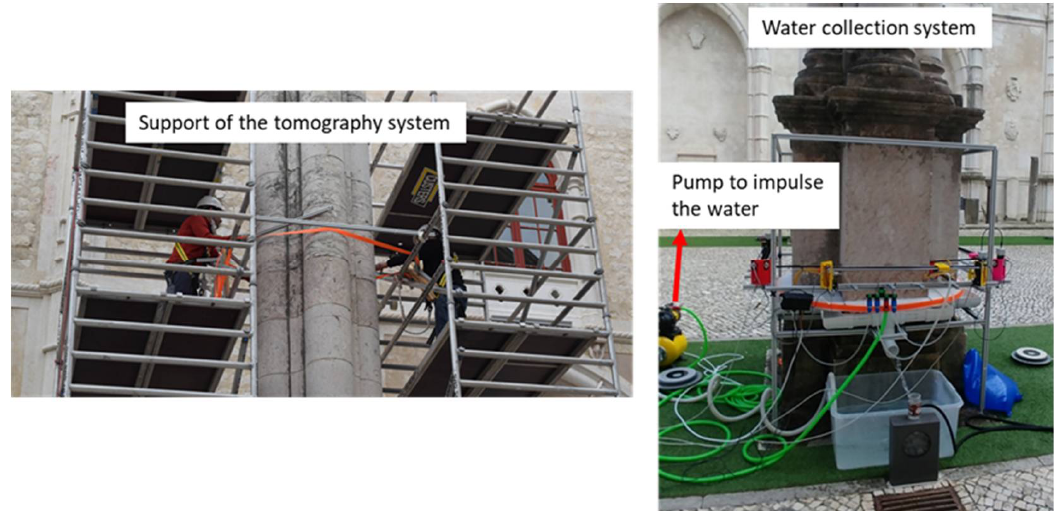
Figure 11. Support of the tomography system on the top of the column, winch to vertical movement, and the system to collect and impulse the water.